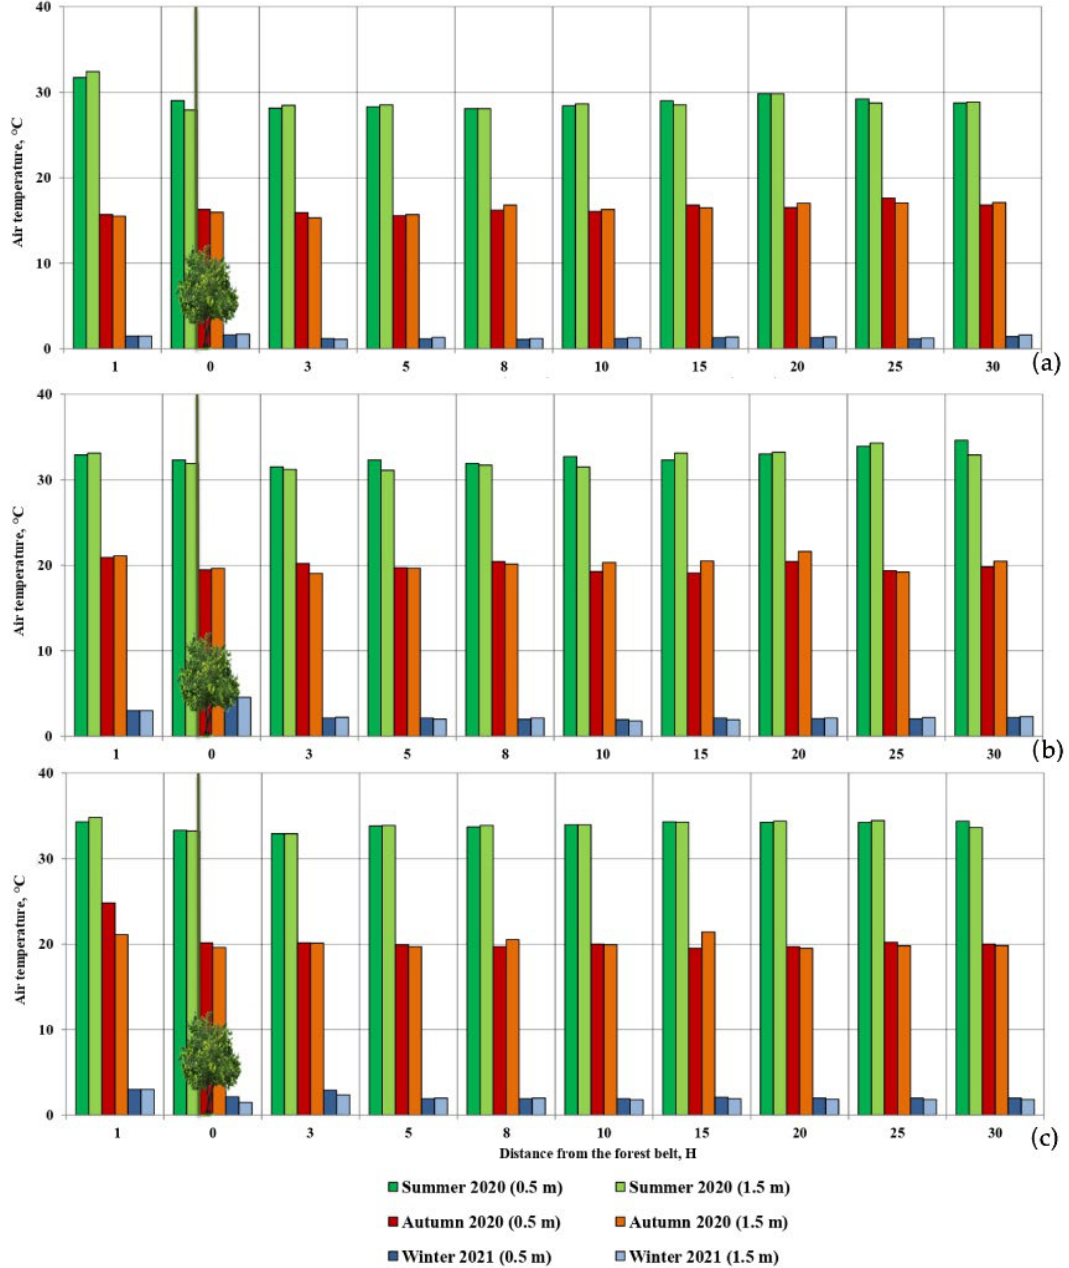
Figure 7. Air temperature in the agrolandscapes of the Kachalinskoe farm in 2020–2021: ( a ) 10 a.m., ( b ) 1 p.m., ( c ) 4 p.m.